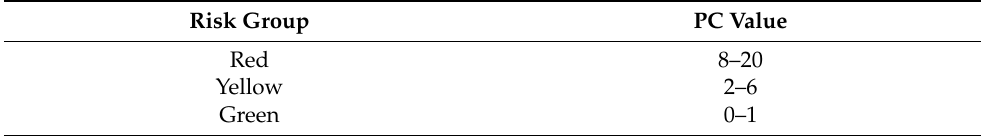
Table 3. Color coding in risk